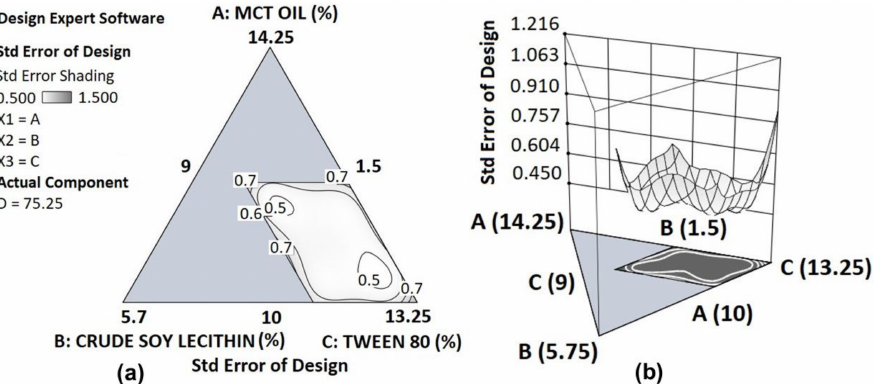
Figure 2. Contour plot ( a ) as well as the surface plot ( b ) of the standard error at different points in the design space with changing compositions of MCT oil (A), crude soy lecithin (B) and Tween 80